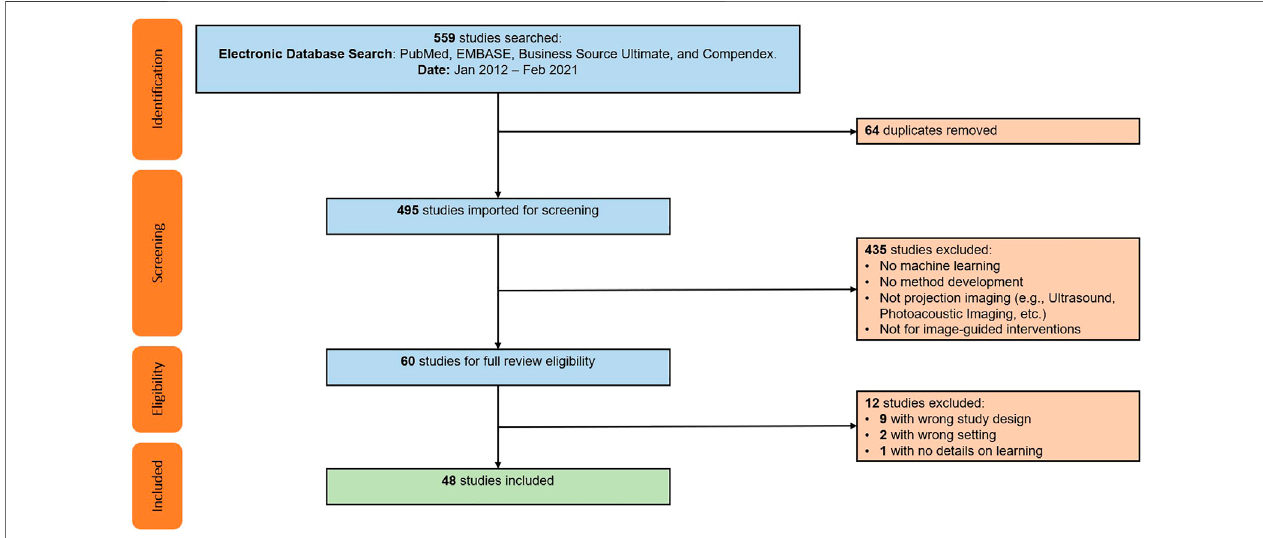
FIGURE 2 | PRISMA fl ow chart illustrating the screening and inclusion process. Duplicate studies were the result of searching multiple databases. Exclusion screeningwasperformed individually witheach study ’ sabstract withassistance ofCovidence tool.Additional twelve studies excludedafter full-text review, resulting ina pool of 48 studies included for full